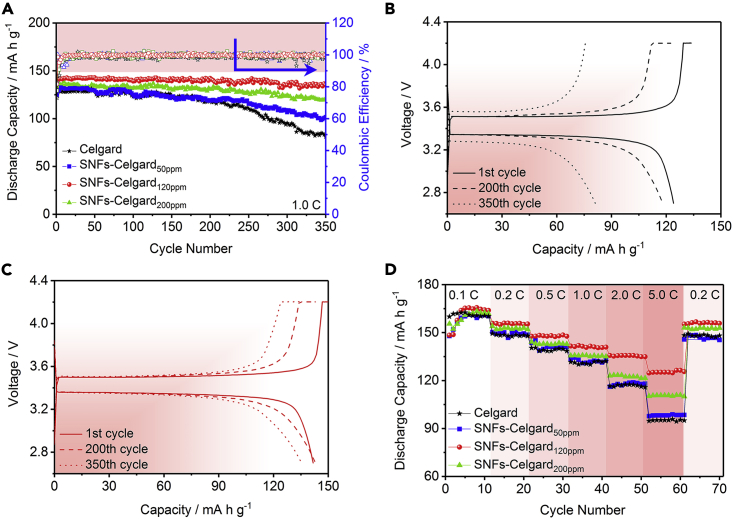
Electrochemical Performance of Cells with SNFs-Celgard Separators(A) Cycling stability of the Li/LiFePO4 cells with different separators.(B and C) Discharge/charge curves of the Li/LiFePO4 cells with the (B) Celgard and (C) SNFs-Celgard120ppm separators. See also Figure S16.(D) Rate performance of the Li/LiFePO4 cells with different separators (1 C = 160 mA h g−1).